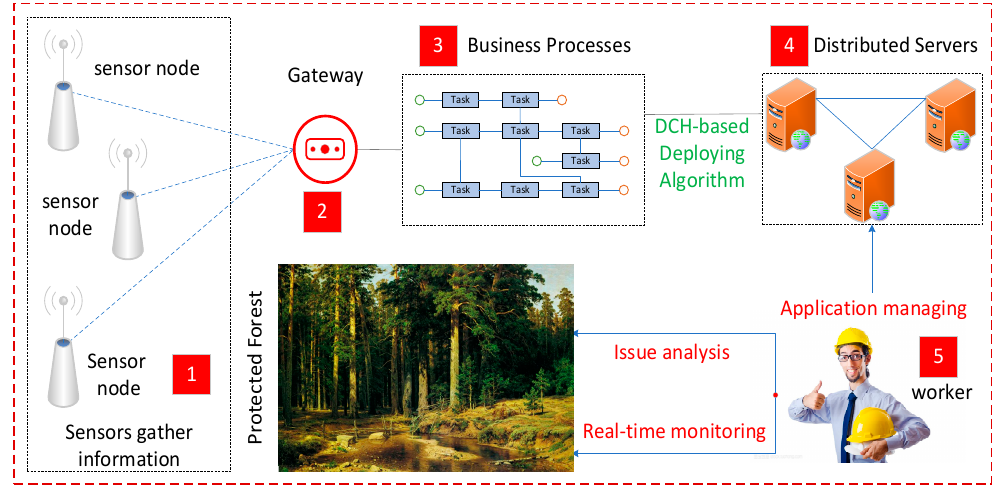
Figure 19. An actual sensor-aware business process application using our designed system